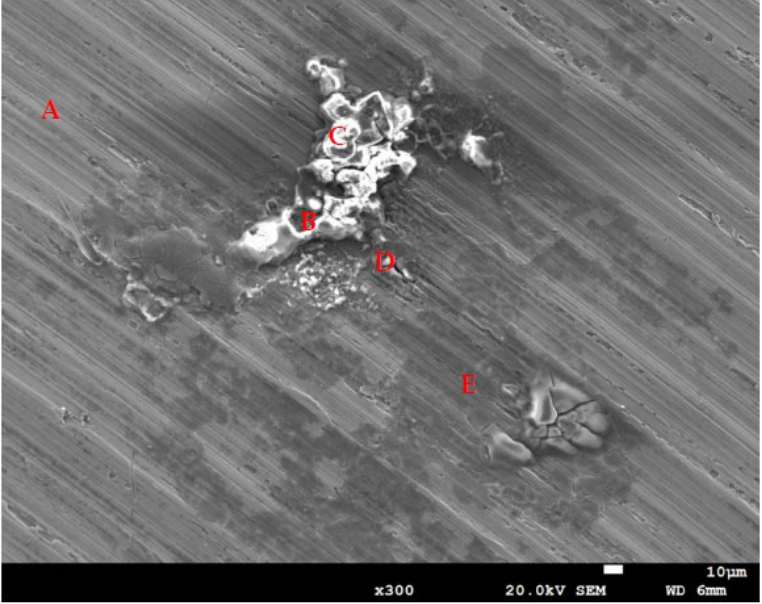
Figure 9. Energy dispersive X-ray spectrometry (EDS) analysis of the corroded regions on those specimens with a 1 g/m 2 chloride deposit after testing at 55% relative humidity for 7000 h. Table 3. Results of the EDS analysis of the corroded regions (wt.%).